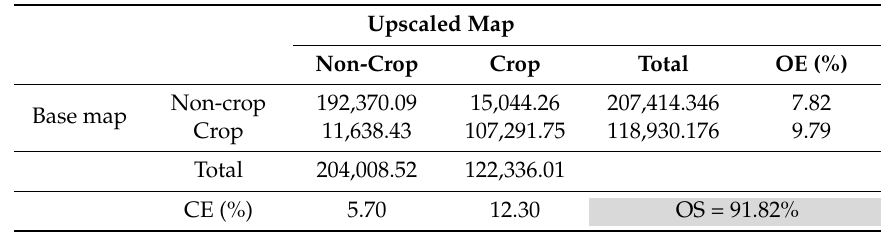
Table 4. An example of similarity matrix for the upscaled map at 240 m of the Heartland region. The unit of area is km 2 .